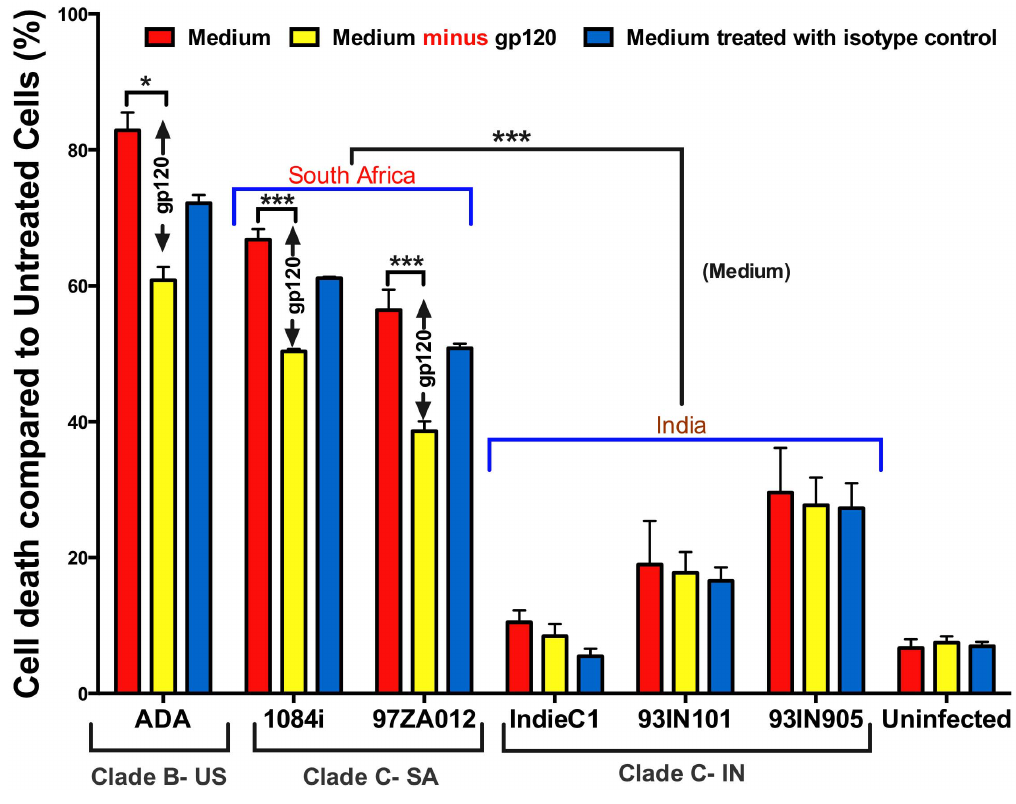
Figure 2. Differential neurotoxicity of Southern African and Indian HIV-1 clade-C isolates. A . gp120 of Indian HIV-1C isolates have minimal neurotoxicity. SH-SY5Y cells were incubated for 24 h with 50 m l of spent medium from PBMCs infected with representative isolates from (US HIV-1B, Southern African HIV-1C and Indian HIV-1C) with approximately similar viral loads. Supernatants were also immunodepleted of gp120 using anti-gp120 VRC03 (AIDS Repository) or Isotype Control IgG1 (BD) antibodies. WST-1 cell viability assay revealed US HIV-1B and Southern African HIV- 1C supernatants caused significantly greater neuronal cell death compared to HIV-1C from India and a significant proportion of neuronal death is due to gp120. The absence of decrease in neurotoxicity upon neutralization of gp120 specifically in the Indian isolates was markedly different from the rest. Medium indicates untreated PBMC supernatants, while ‘Medium minus gp120’ refers to gp120 immunodepleted medium. An average of 2 Southern African isolates (medium) and of the 3 Indian isolates were compared. (* p , 0.05; *** p , 0.005).